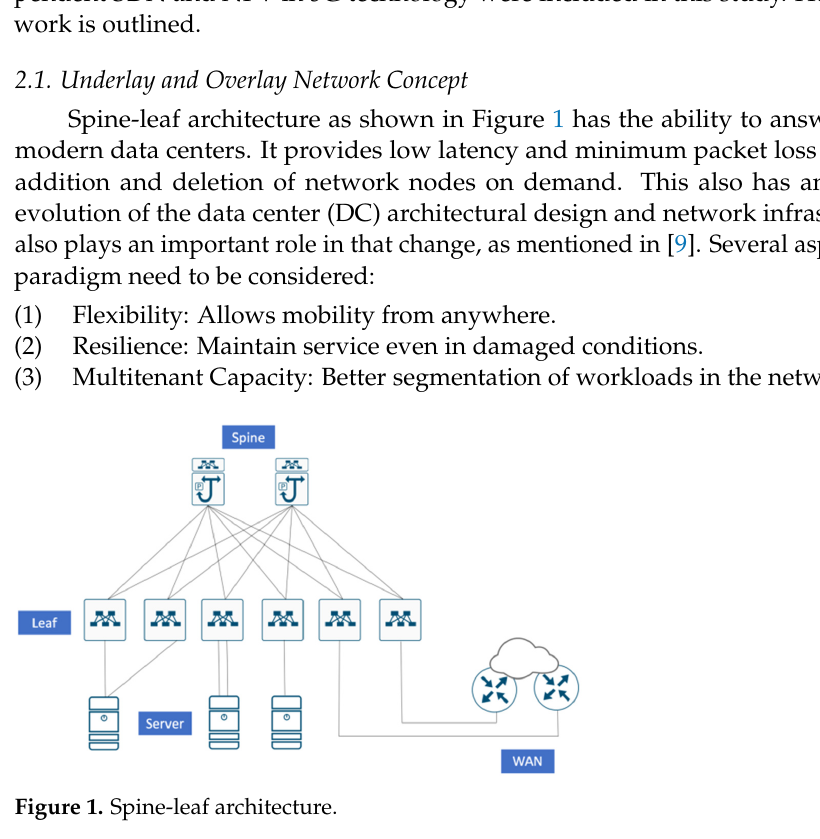
Figure 1. Spine-leaf architecture.